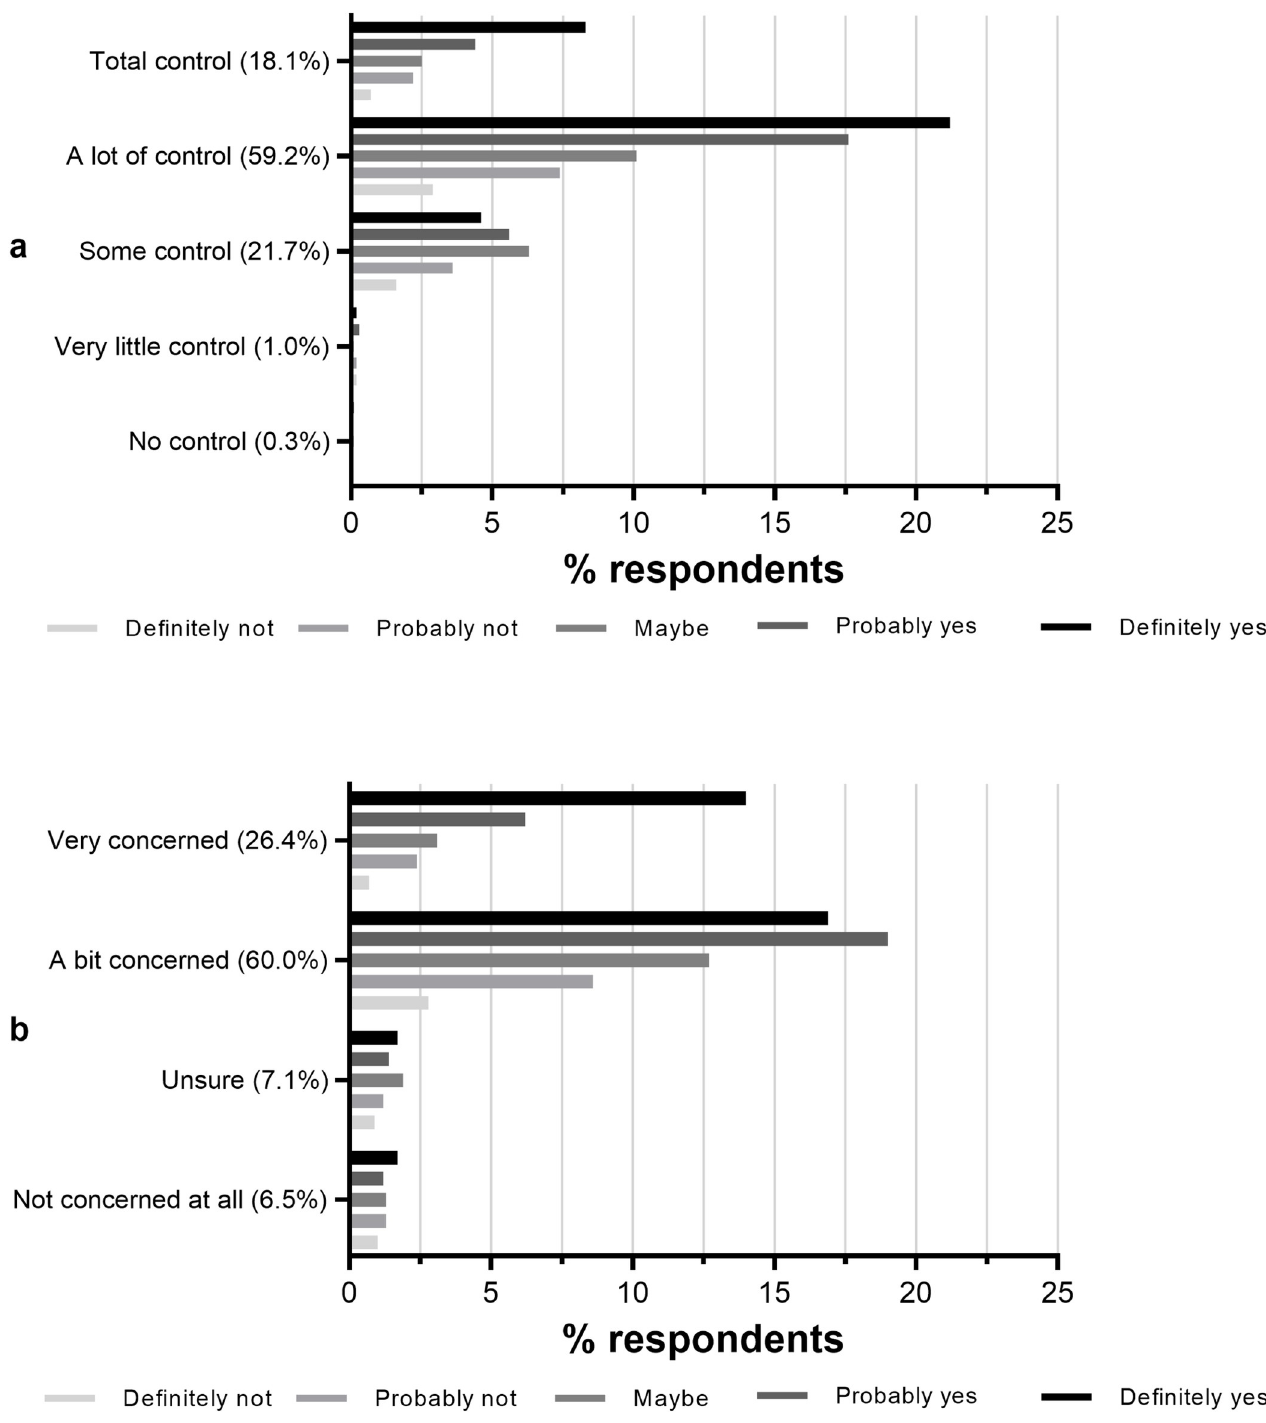
Fig 4. Cross-tabulations of ‘Would you like to know this information?’ with: a) ‘How much control do you think caregivers/parents have over their child’s weight?’ (n = 1,867) and b) ‘How concerned would you be if you thought your child was gaining too much weight?’ (n = 1,867). Y axes’ percentages for A and B represent overall % of responses to that